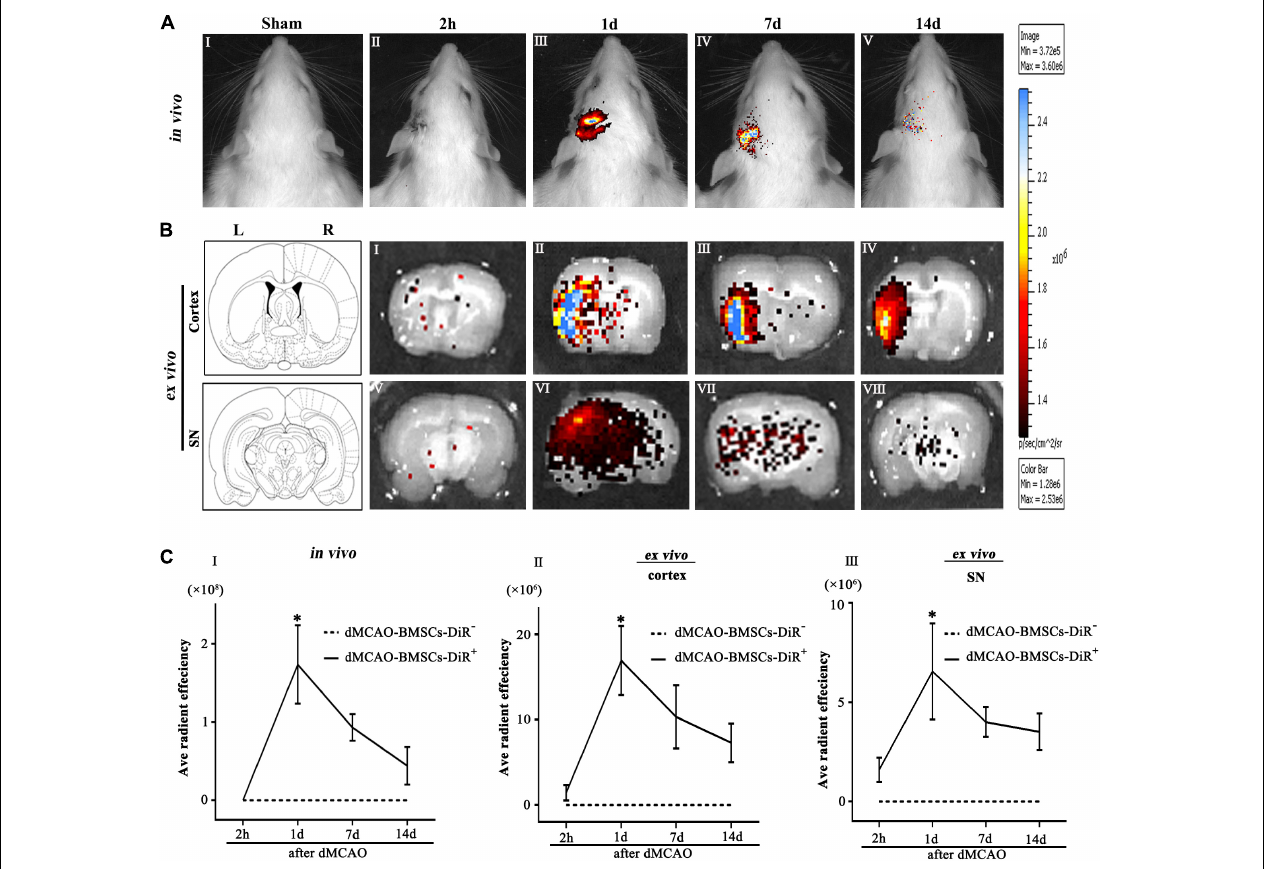
FIGURE 2 | Transplanted BMSCs migrate to the ipsilateral SN after dMCAO in rats. (A) The in vivo fluorescence images of migrated BMSCs-DiR + in the brain at 2 h and 1, 7, 14 days post-intravenous transplantation following focal cortical infarction. (B) The ex vivo fluorescence images of migrated BMSCs-DiR + in the cortex (I–IV) and SN (V–VIII) at 2 h and 1, 7, 14 days post-intravenous transplantation following focal cortical infarction. (C) Quantitative analyses ( in vivo and ex vivo ) of migrated BMSCs-DiR + in the brain (I) , cortex (II) , and SN (III) at 2 h and 1, 7, 14 days post-intravenous transplantation following focal cortical infarction. Compared with the sham-operated group, the fluorescence intensities of BMSCs-DiR + groups both in viv o [ F ( 4 , 25 ) = 7.67, p < 0.01] and ex vivo [cortex: F ( 4 , 25 ) = 6.58, p < 0.01, SN: F ( 4 , 25 ) = 4.09, p < 0.05] were significantly increased. ∗ p < 0.05 vs. BMSCs-DiR - group ( n = 7 in each group). Sham, sham-operated; h, hour; d, day; w, week; L, left; R, right; SN, substantia nigra; dMCAO, distal middle cerebral artery occlusion; BMSCs, bone marrow stromal cells; DiR (1,1-dioctadecyltetramethyl indotricarbocyanine iodide); DiR + , DiR-labeled; DiR − ,